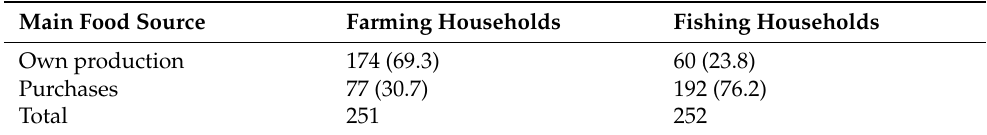
Table 3. Main food sources of